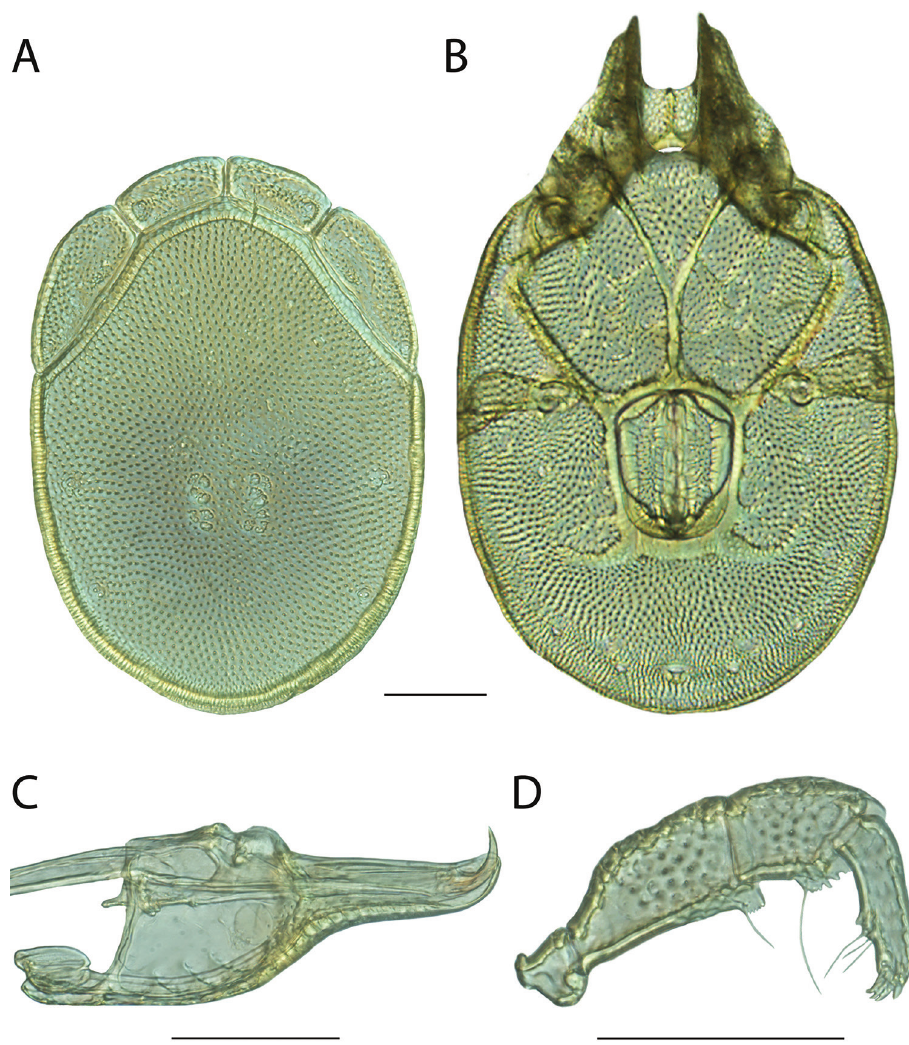
Figure 142. Torrenticola manni sp. n. male: A dorsal plates B venter (legs removed) C subcapitulum D pedipalp (setae not accurately depicted). Scale = 100